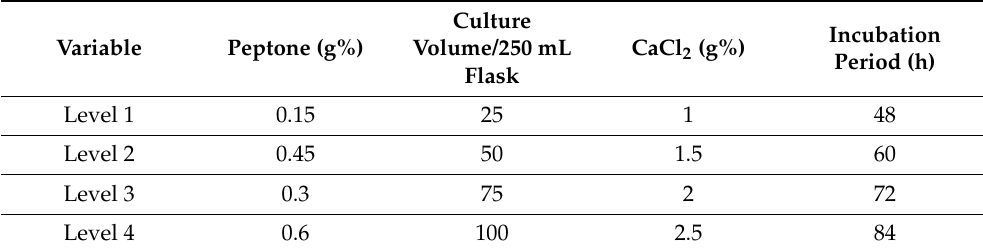
Table 2. Variables affecting the production of alpha-amylase by the MS009 isolate, and their levels in the central composite